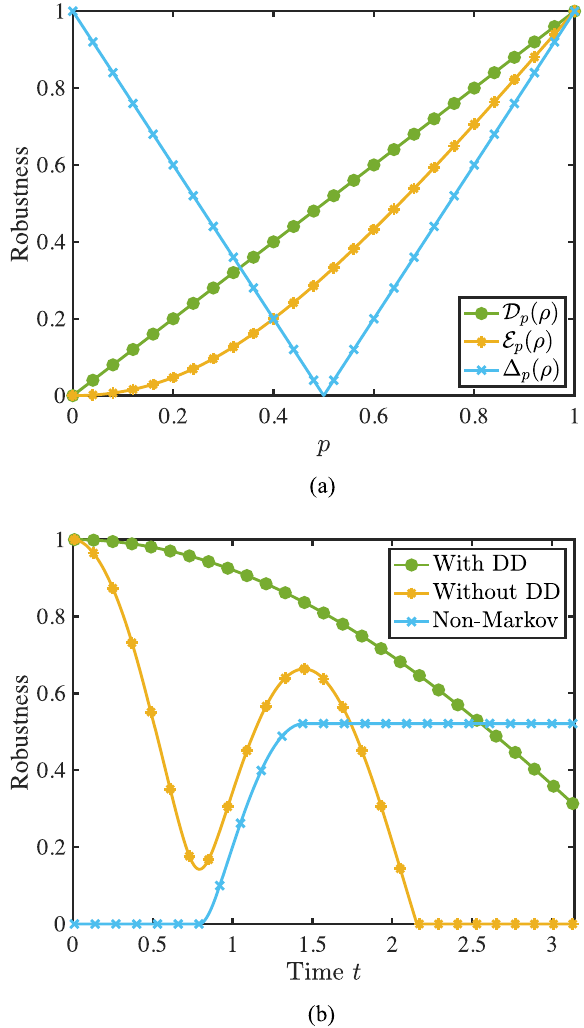
Fig. 2 Numerical evaluation of the exact value of robustness of quantum memories. a Robustness of memories with qubit inputs and computational basis f 0 j i ; 1 j ig for dephasing channels